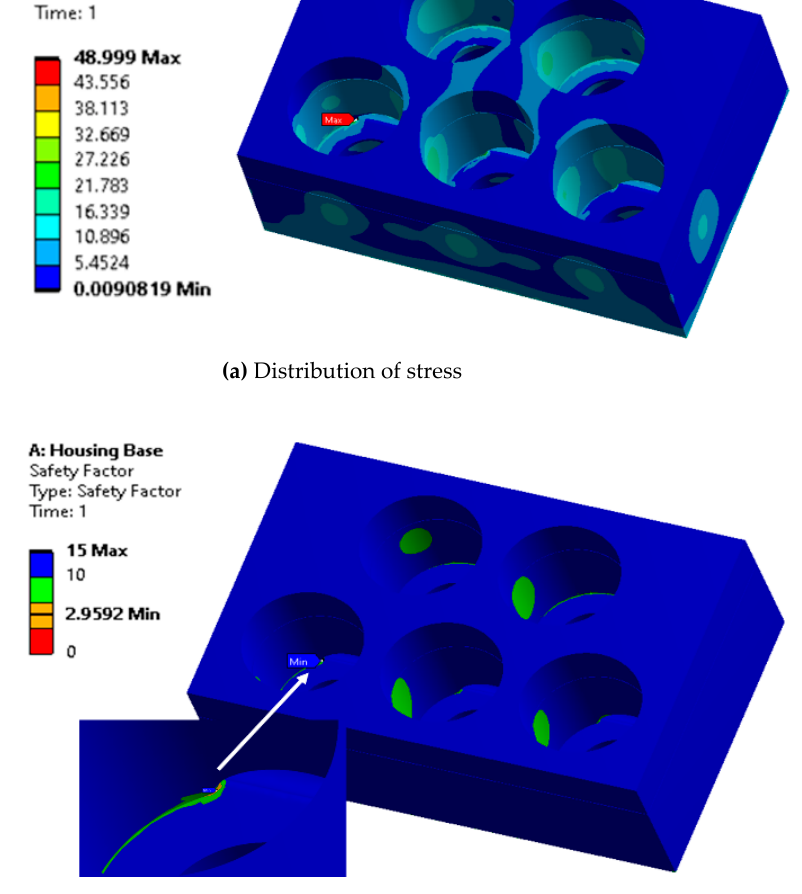
(c) Distribution of total deformation Figure 7. Analysis results for the housing base. Figure 8 shows the simulation results of the stress, safety factor and deformation dis- tribution in the cylinder shaft. In the cylinder shaft, the maximum stress of 21.3 MPa